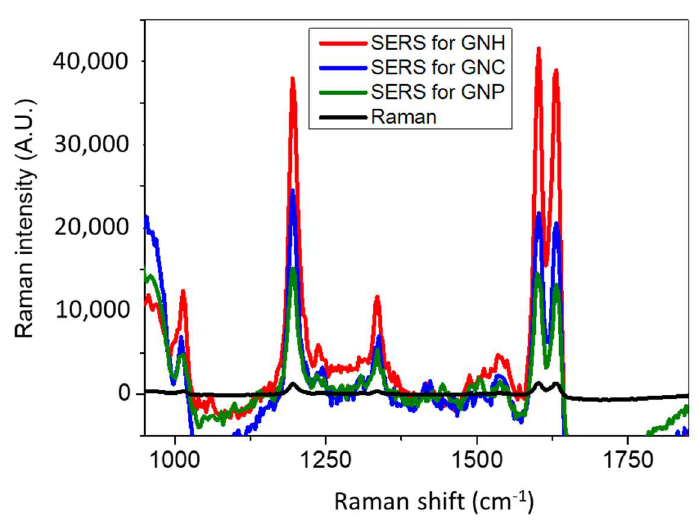
Figure 6. SERS spectra of 10 − 12 M of BPE probed with three different shapes of GNP. Raman measurements were obtained with 10 − 2 M of BPE. Spectra were obtained with a 632.8 nm laser at P = 10 mW and acquisition time = 10 s. Each curve is an average of 10 spectra collected from different positions on the substrate.